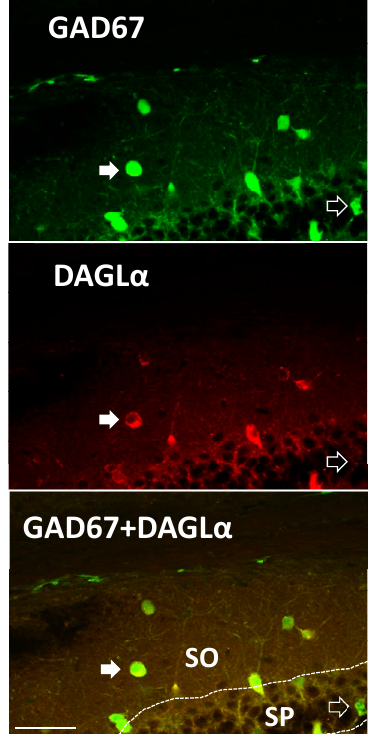
Figure 4. DAGL α is expressed in a subset of mouse hippocampal interneurons. GAD67-green fluorescent protein (GFP) knock-in mice were probed for DAGL α expression. We observed DAGL α immunoreactivity in the cytosol of GAD67-GFP stratum oriens (SO) interneurons and pyramidal cells of the stratum pyramidale (SP). Semi-quantitative analysis of co-labeling occurred in ~64% of GAD67-positive neurons in the same region as physiological recordings ( n = 31 of 48; from slices in three different mouse brains of dorsal CA1). Closed arrows illustrate an interneuron that is double labeled with GAD67-GFP and DAGL α in the oriens. Open arrow denotes a GAD67-GFP labeled, DAGL α -negative neuron in the SP. GAD67-positive cells include populations of PV+ and SOM+ cells [31]. Scale Bar: 50 µm.